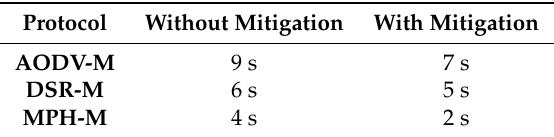
Table 9. Resilience in seconds for AODV, DSR and